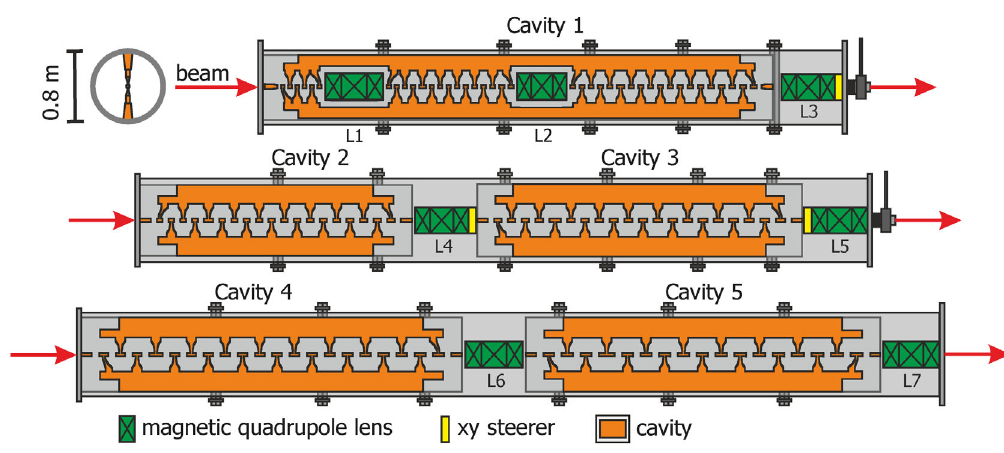
FIG. 24. Layout of the five IH-DTL cavities comprising three separate rigid